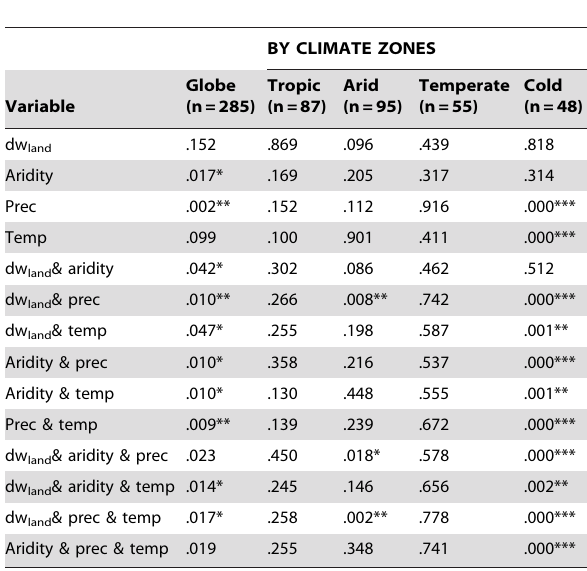
Table 5. Results of the bivariate and multiple regression analysis.